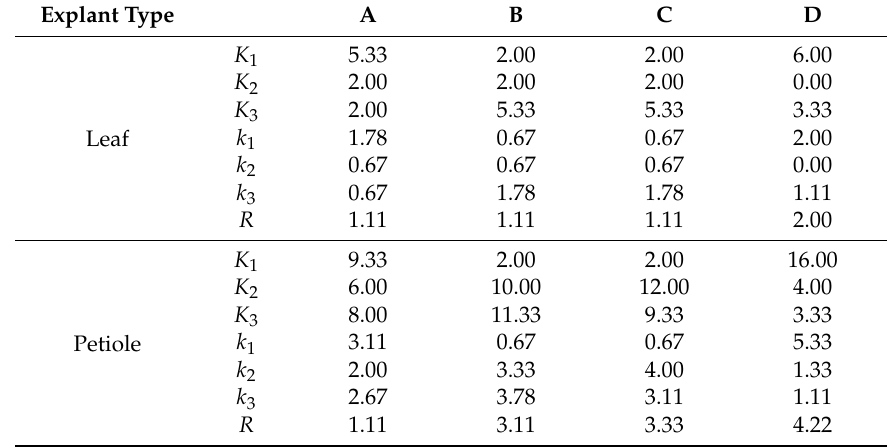
Figure 3. Chromosome counting of regenerated Liquidambar styraciflua × L. formosana plant ( a ) Chromosomes of a tetraploid plant. ( b ) Chromosomes of a diploid plant.